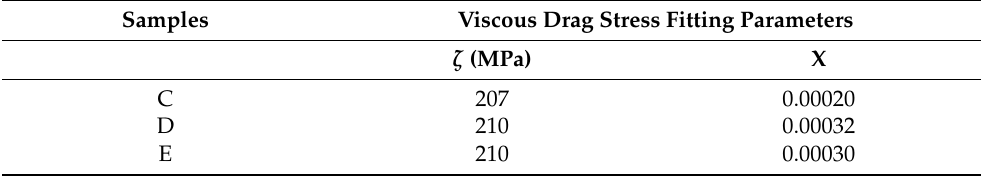
Table 5. A summary of constitutive flow stress model parameters for DMLS Ti6Al4V(ELI).